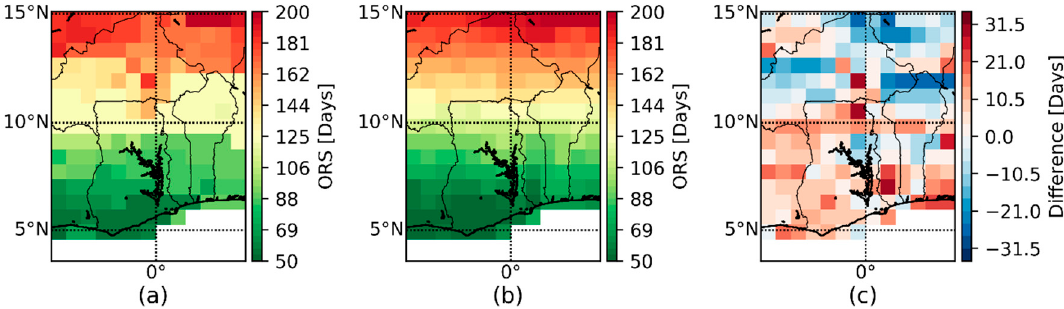
Figure 11. ( a ) ORS from CHIRPS (Julian day) in 2001, ( b ) ORS climatological mean from CHIRPS (1981–2010) and ( c ) difference between ( a , b ).